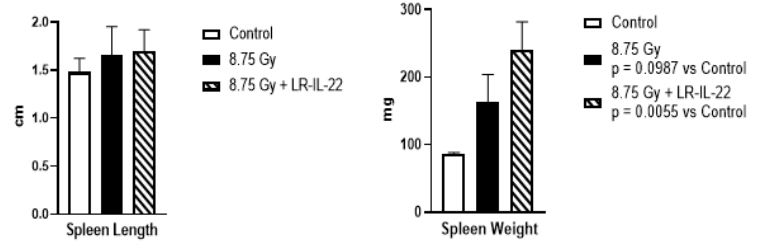
Figure 5. LR-IL-22 stimulates recovery of spleen weight and length at 21 days after total body irradiation (TBI). C57BL/6NTac mice were irradiated to 8.75 Gy TBI. Subgroups of mice were gavaged with LR-IL-22 at 24 h after irradiation. Twenty-one days following irradiation, mice were euthanized and the spleen was removed, weighed, and length measured ( n = 4 or 5 mice). Results are presented as mean + standard error of the mean.